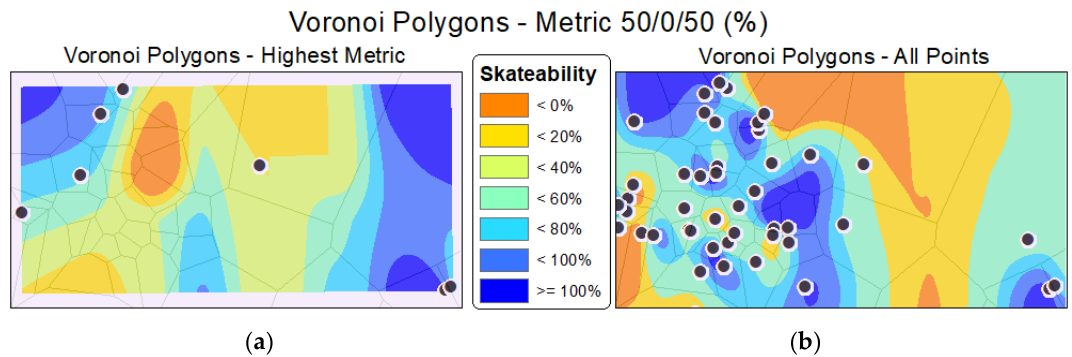
Figure 6. Using Voronoi polygons, a spline interpolation surface fit based on rink skateability. The left surfaces ( a ) are the optimal areas with the right surfaces ( b ) showing the complete study area. Index component weightings are coverage 50%, user-heterogeneity 0%, and density 50%.